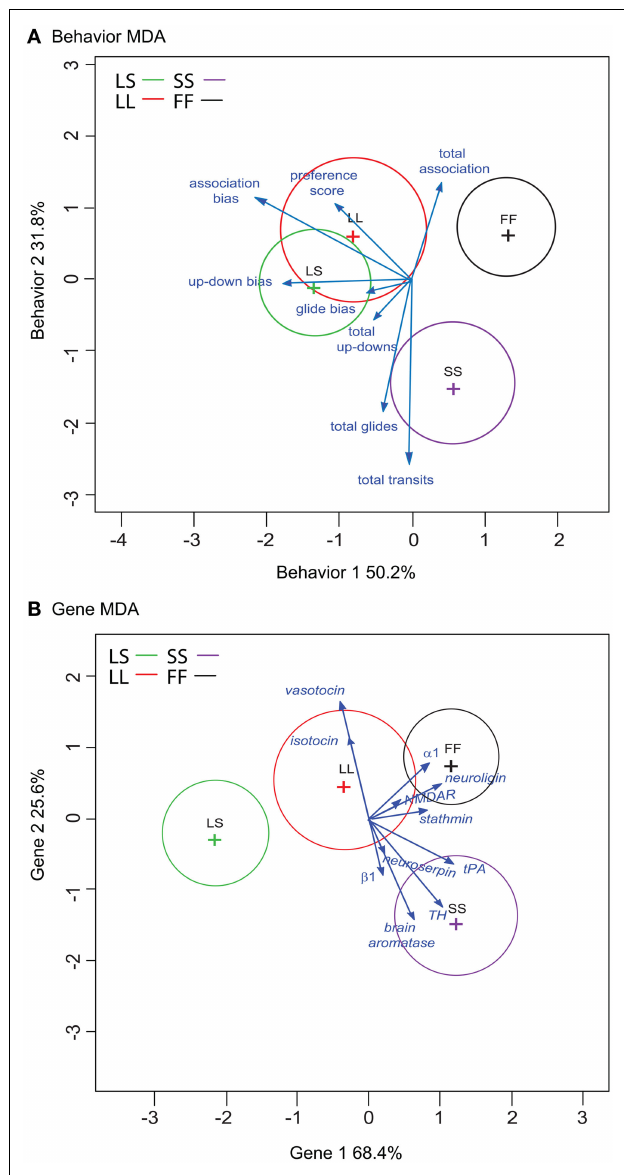
FIGURE 3 | Spatial relationship of eight behaviors (A) and 11 input gene variables (B) onto MDAAxes. Circles represent the 95% confidence ellipses around each multivariate centroid (multivariate least squares mean for each treatment group), and the vectors represent the orientation in multidimensional space along the two primary axes Axis 1 ( x -axis) and Axis 2 ( y -axis) for each behavior (A) or gene (B) MDA.Vectors are scaled for the plot space, and vector length indicates the potency of each variable in terms of discriminating between groups. For each input variable, the vector points toward groups with higher mean values, and away from groups with lower mean values. Groups are plotted by color, LS = green, LL = red, SS = purple, and FF =